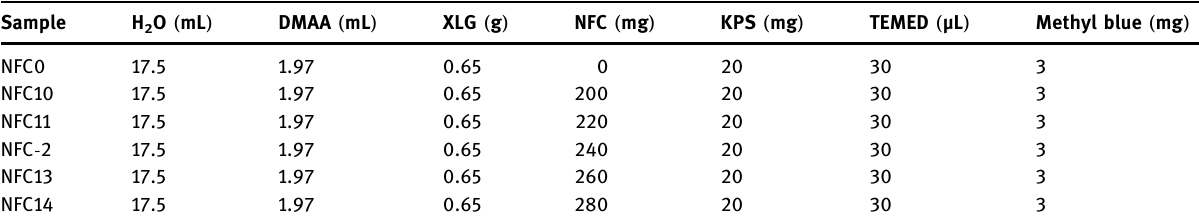
Table 1: Compositions of intelligent hydrogels